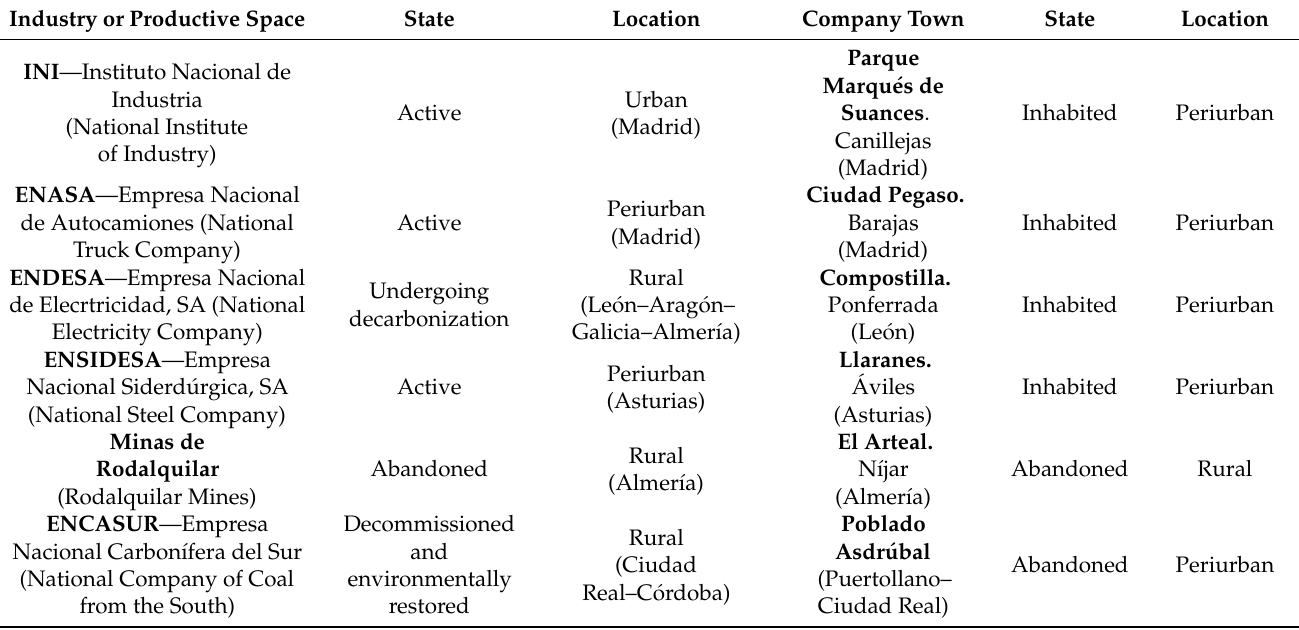
Table 2. Studies sites of sampling